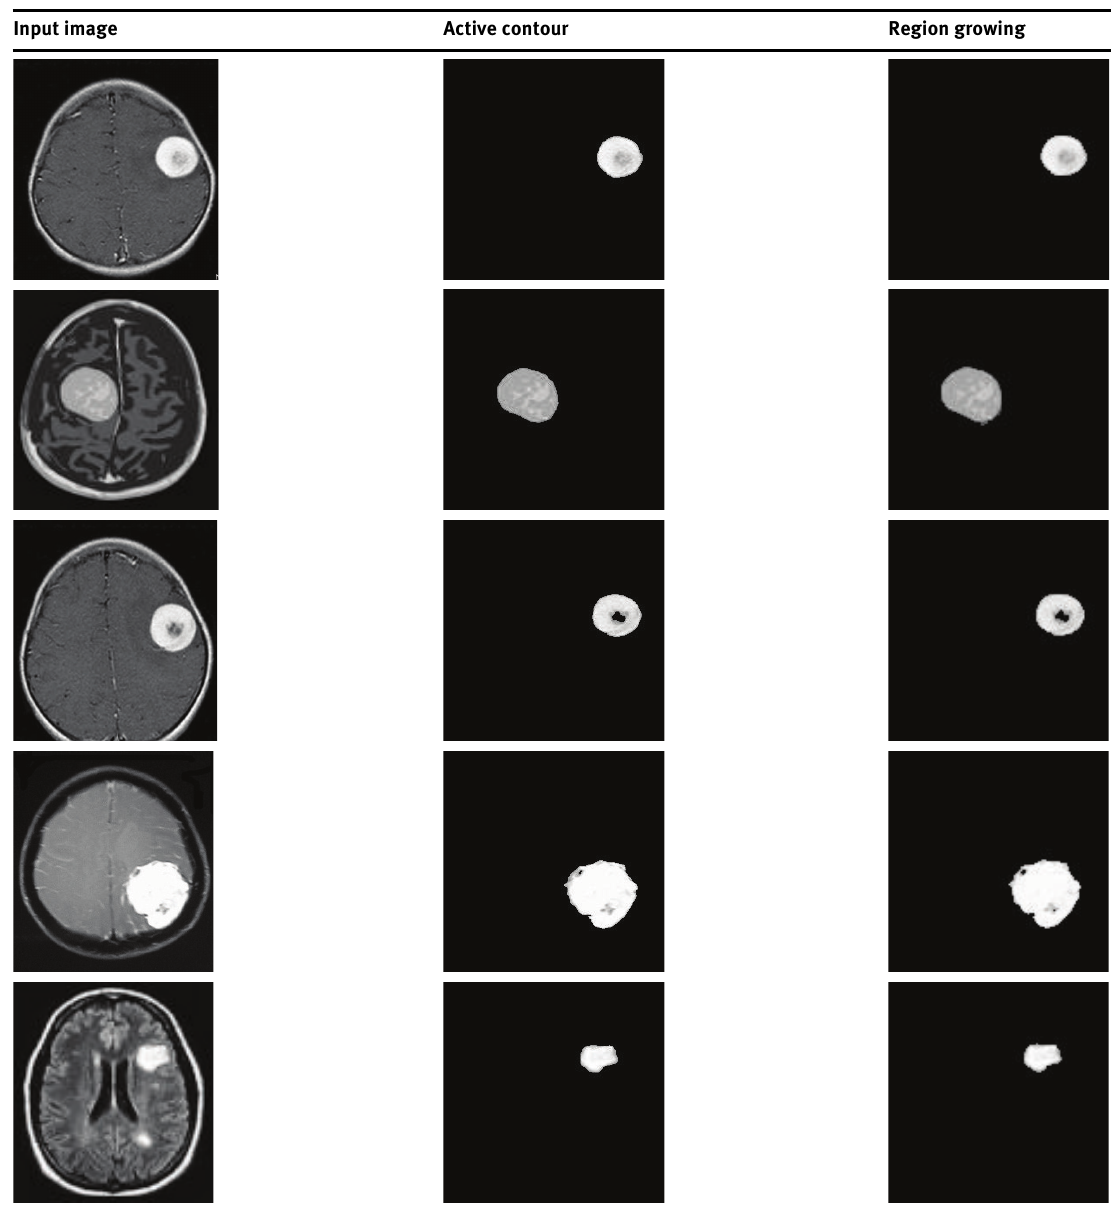
Table 7: A Visual Representation of Segmentation